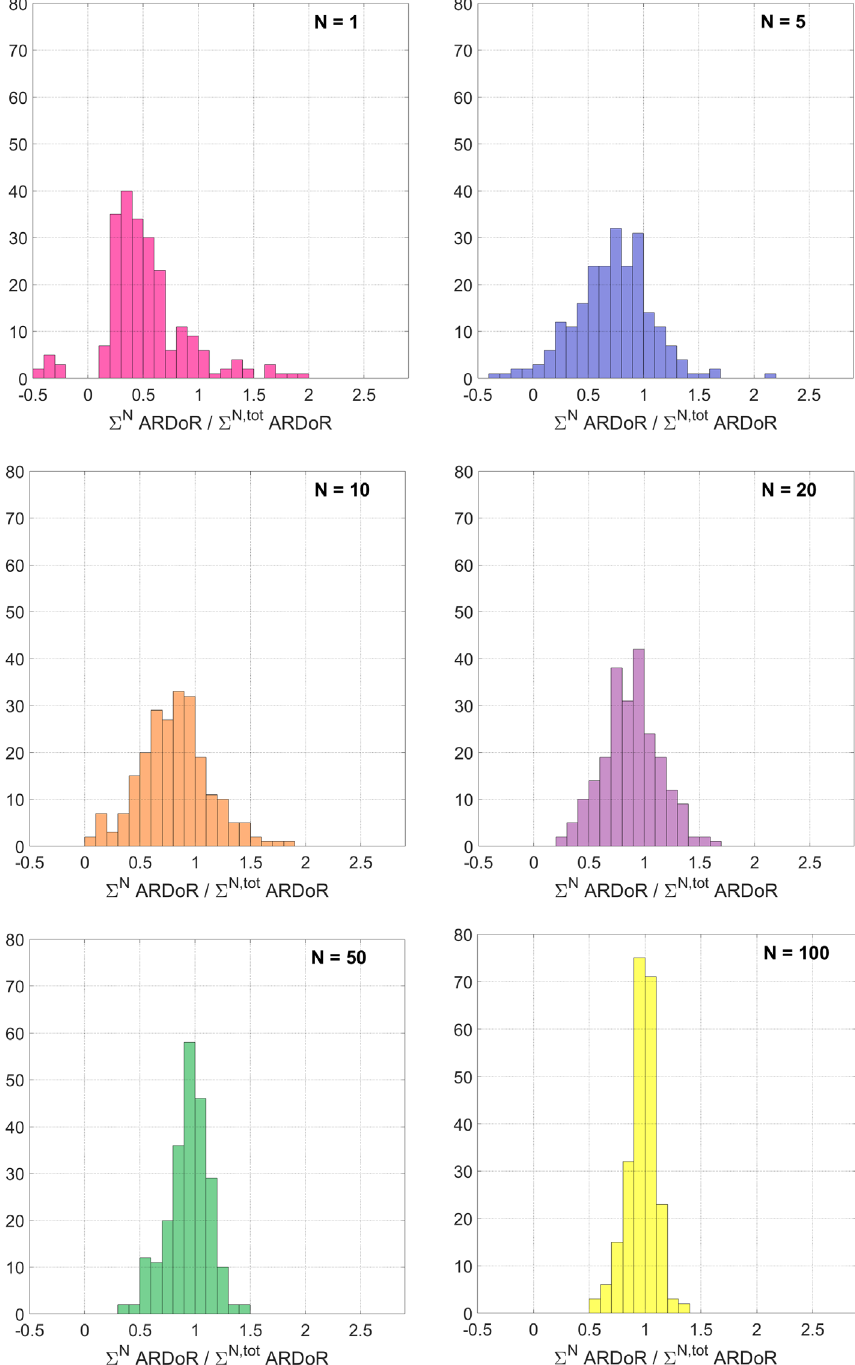
Fig. 2. Histograms of the total ARDoR of the top N ARs divided by the total ARDoR of all ARs for cycles where the total ARDoR exceeds 15% of the absolute change in the dipole moment D D (230 cycles). The value of N is shown inside each